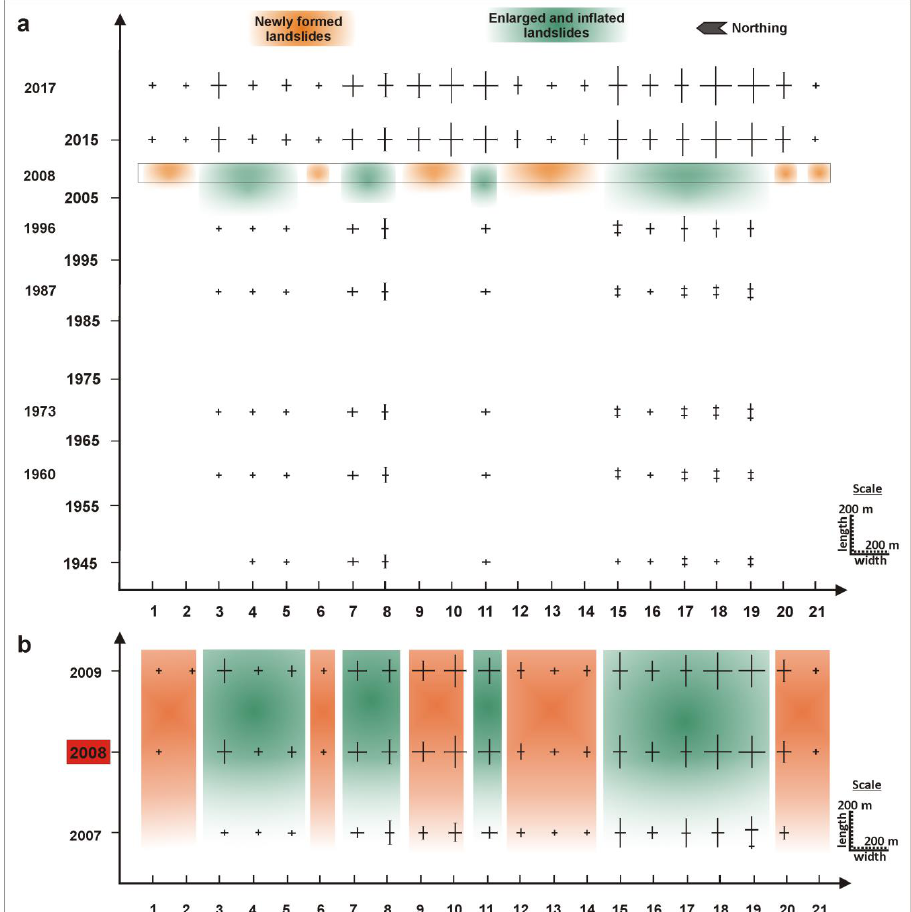
Figure 6. Map of length and width evolution of the 21 landslides appeared in Figure 5, in the Santomerion area. Crosses show dimensions of pre-earthquake landslide and their evolution over time. Asymmetrical crosses represent their inflation and/or enlargement, double crosses indicate coalescence of two or more landslides due to earthquake activity: ( a ) The orange rectangles show the newly formed landslides. The green rectangles show the evolved pre-earthquake landslides; ( b ) Mapping of the inflation and/or enlargement of 2008 earthquake triggered or reactivated landslides. The dark color indicates inflated and/or enlarged landslides after the 2008 earthquake, while the blur suggests more or less stable landslides.